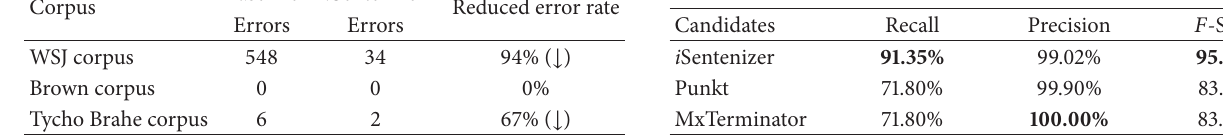
Table 11: Trained on the Brown corpus and tested on the Tycho Brahe corpus.